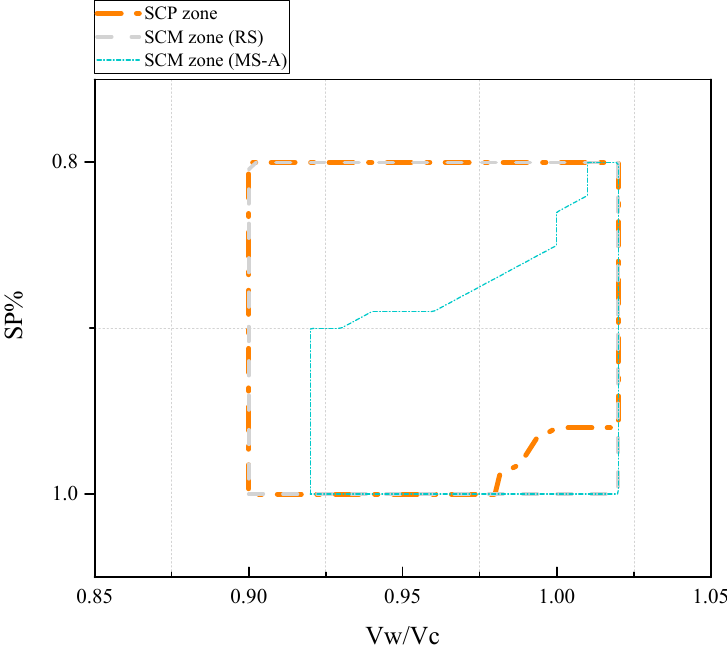
Figure 9. SCP zone and SCM zones for RS and MS-A. However, the SCM zone for MS-A coincided partially with the SCP zone, and the SCM zone for MS-A moved a distance to the right relative to the SCM zone for RS. RS and MS-A had the same mass and grading, but different particle shapes and specific gravity. More specifically, sands with different specific gravities have different shape properties such as LWS and ROS , and these make the SCM zones